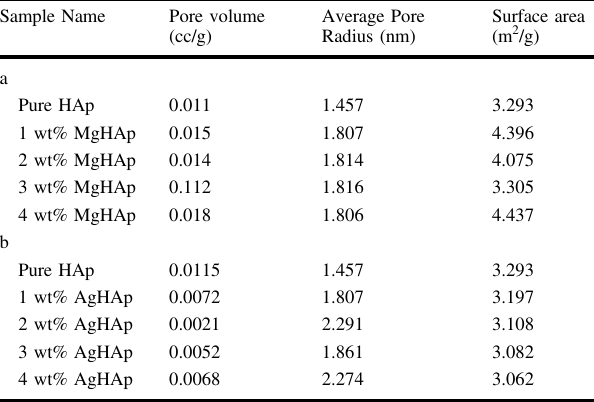
Table 4 a: The pore size and pore volume for various MgHAp samples. b: The pore size and pore volume for the various AgHAp samples